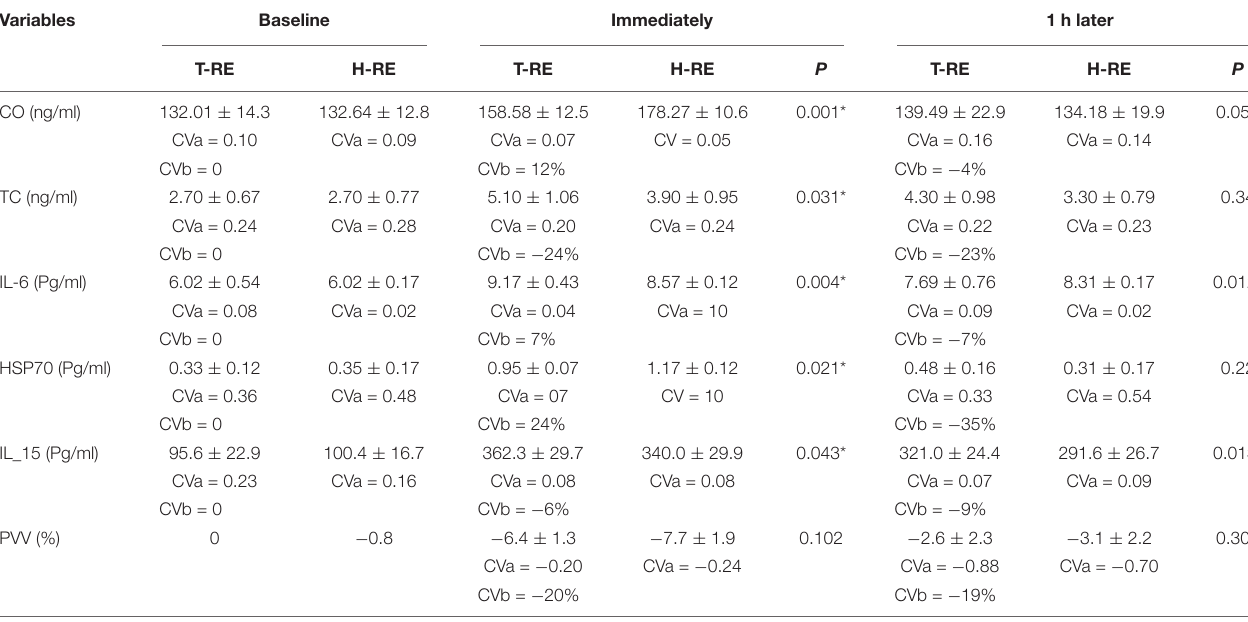
TABLE 1 | Mean ± SD, serum concentrations of CO (cortisol), TC (testosterone), IL-6, HSP70, IL-15 and PVV (plasma volume varation) in the baseline (1-h pre-protocol), immediately after protocols, and 1-h later in the H-RE (heated resistance exercise) and T-RE (thermoneutral resistance exercise) conditions. Variables Baseline